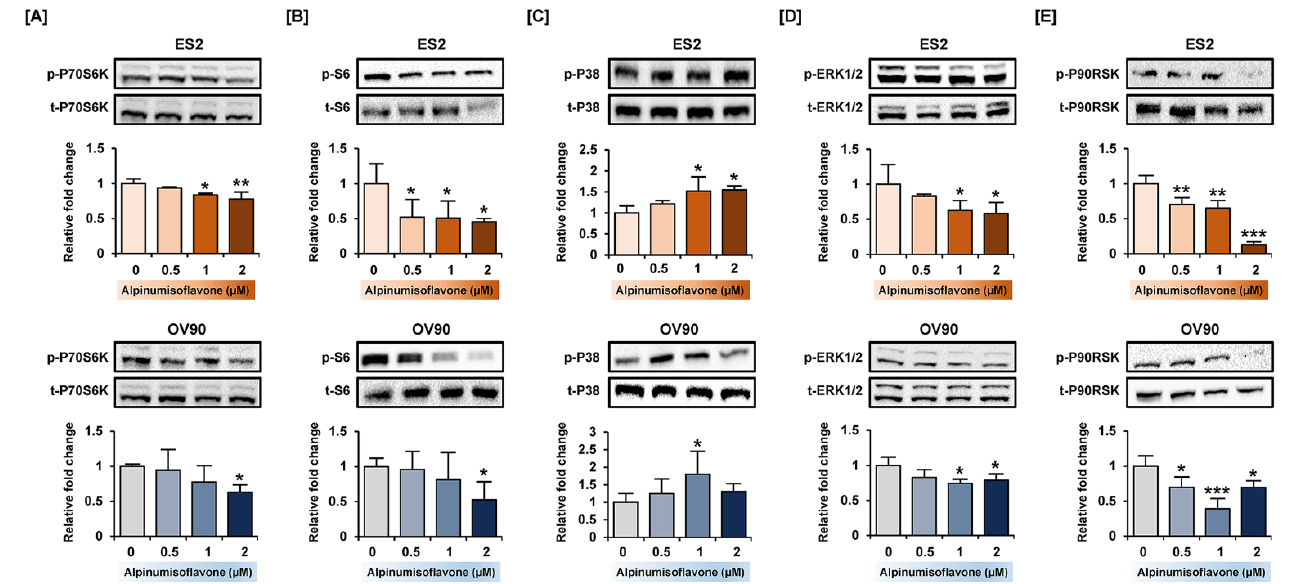
Figure 6. Relative intensity of proteins belonging to PI3K and MAPK signaling pathway in ES2 and OV90 cells treated with alpinumisoflavone. ( A – E ) Phosphorylation of P70S6K ( A ), S6 ( B ), P38 ( C ), ERK1/2 ( D ) and P90RSK ( E ) proteins in immunoblots as analyzed in ES2 and OV90 cells at different alpinumisoflavone doses (0, 0.5, 1 and 2 µM) for 24 h. The standardized values of the phosphorylated proteins are normalized by the intensity of total protein levels. All experiments were performed in triplicate. The significance between the vehicle and treatment groups are depicted by asterisks (* p < 0.05, ** p < 0.01 and *** p < 0.001).